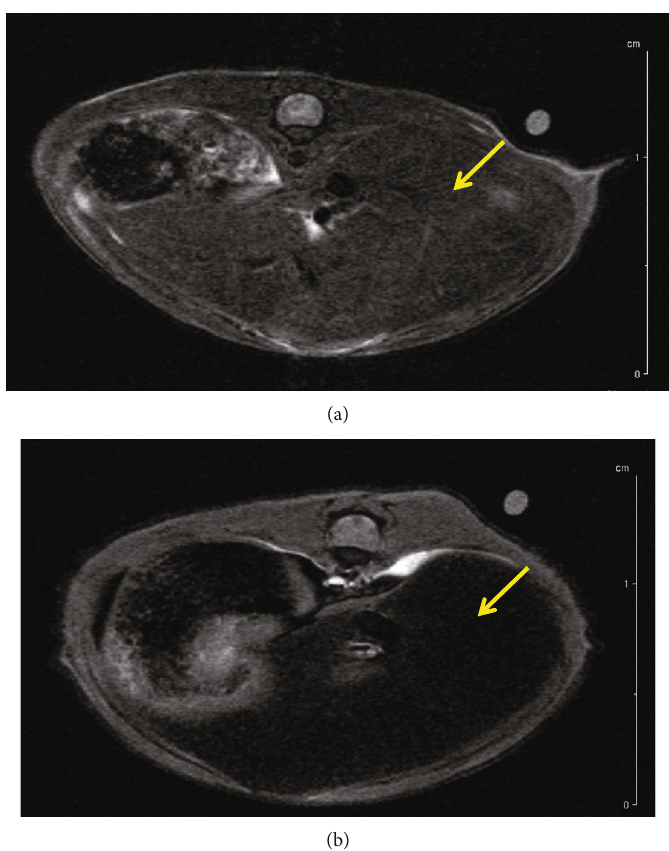
Figure 3: RARE-liver prescan (a); RARE-liver 10min p.i.